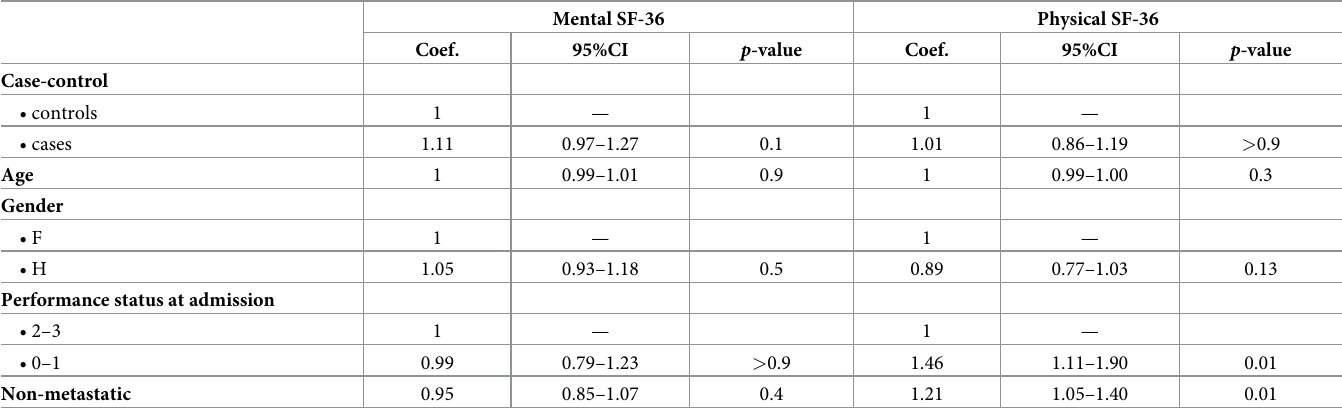
Table 4. Multivariate analysis of variables associated with SF-36 at 3